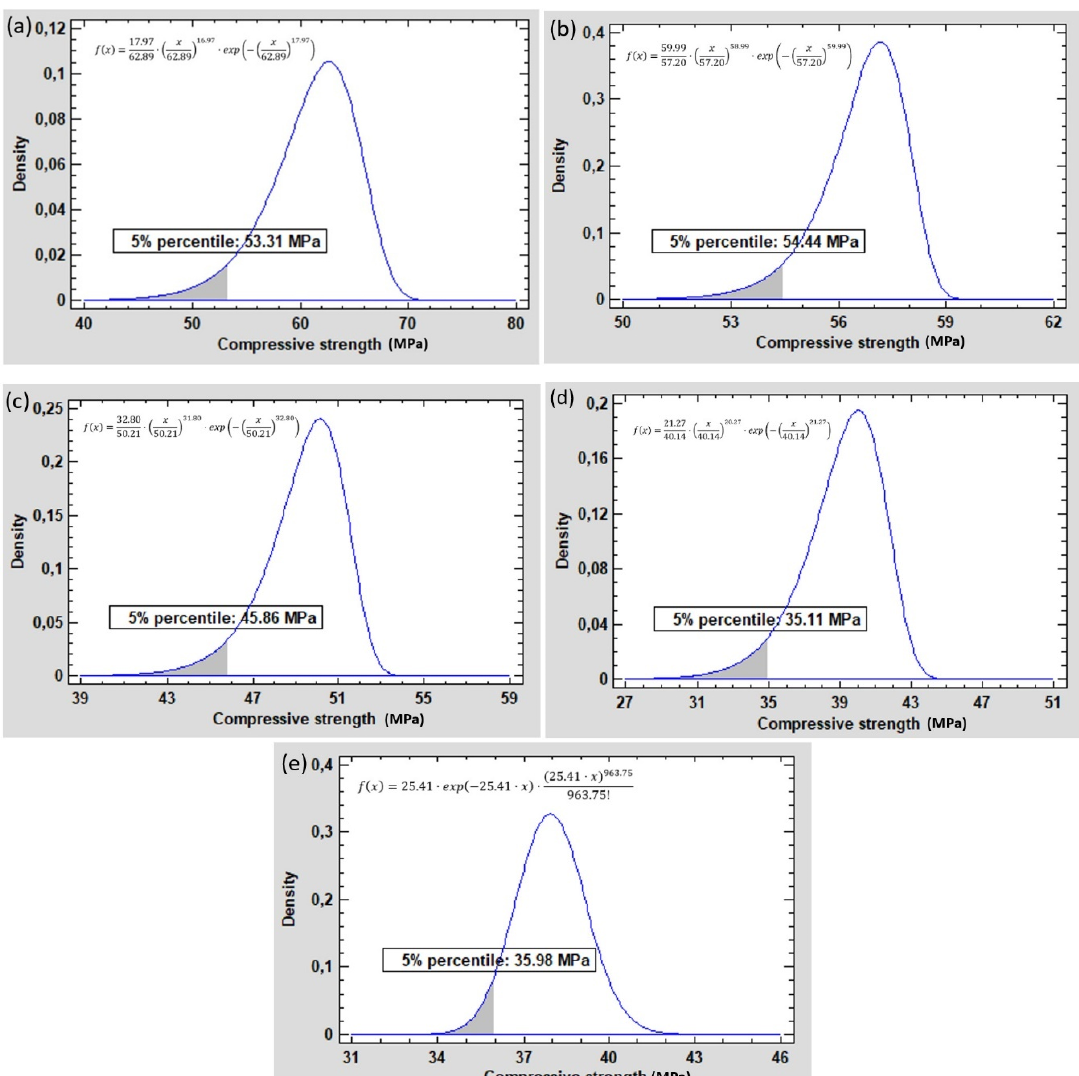
Figure 10. Graph of the characteristic compressive strength for the best-fit distribution (Weibull and